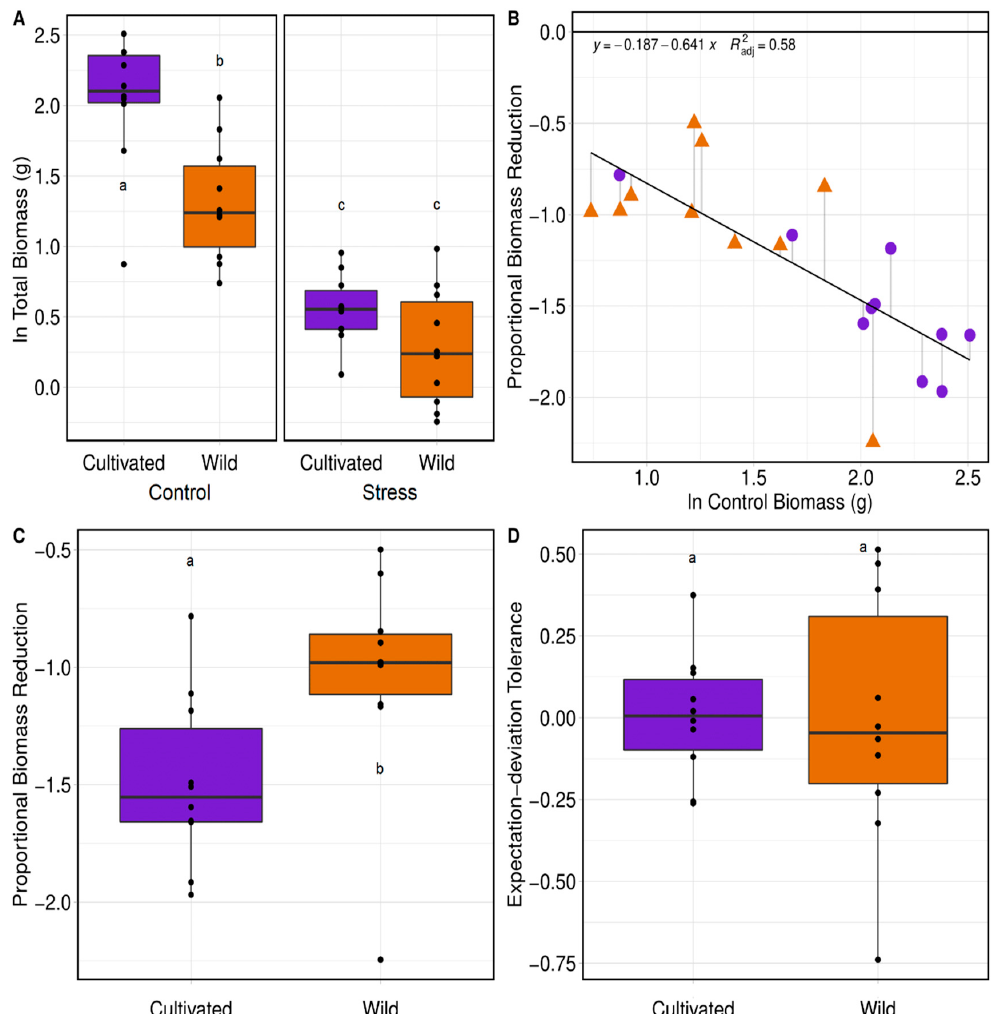
Figure 1. The effect of salinity stress on biomass in wild and cultivated H. annuus . Points indicate accession means. ( A ) Accession means of natural log (ln) transformed total plant biomass by domestication status and salinity treatments. ( B ) The relationship of vigor (biomass under control conditions) and the proportional decrease in biomass. The residuals (gray lines) of each accession reflect expectation-deviation tolerance. ( C ) Accession means of proportional reduction in total biomass by domestication status. ( D ) Accession means of expectation-deviation tolerance (residuals from 1B) by domestication status. Purple circles indicate cultivated accessions and orange triangles indicate wild accessions. Different lower-case letters denote significant differences ( p < 0.05) based on post-hoc contrasts from Tukey-HSD tests (Table 1). Table 1. Mean values of non-elemental plant traits and p-value significance of Wald’s Chi-square test on treatment, domestication status, and their interaction (treatment x domestication status). Trait